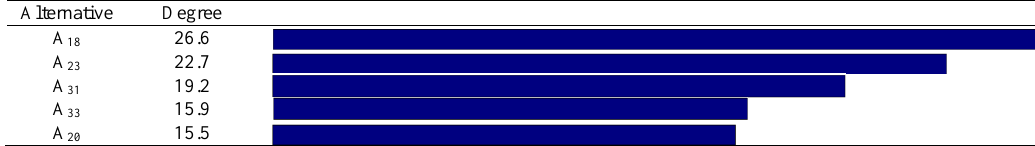
Table 6. Comparison of alternative preference according to the criteria of proportion and adaptation to the environment.